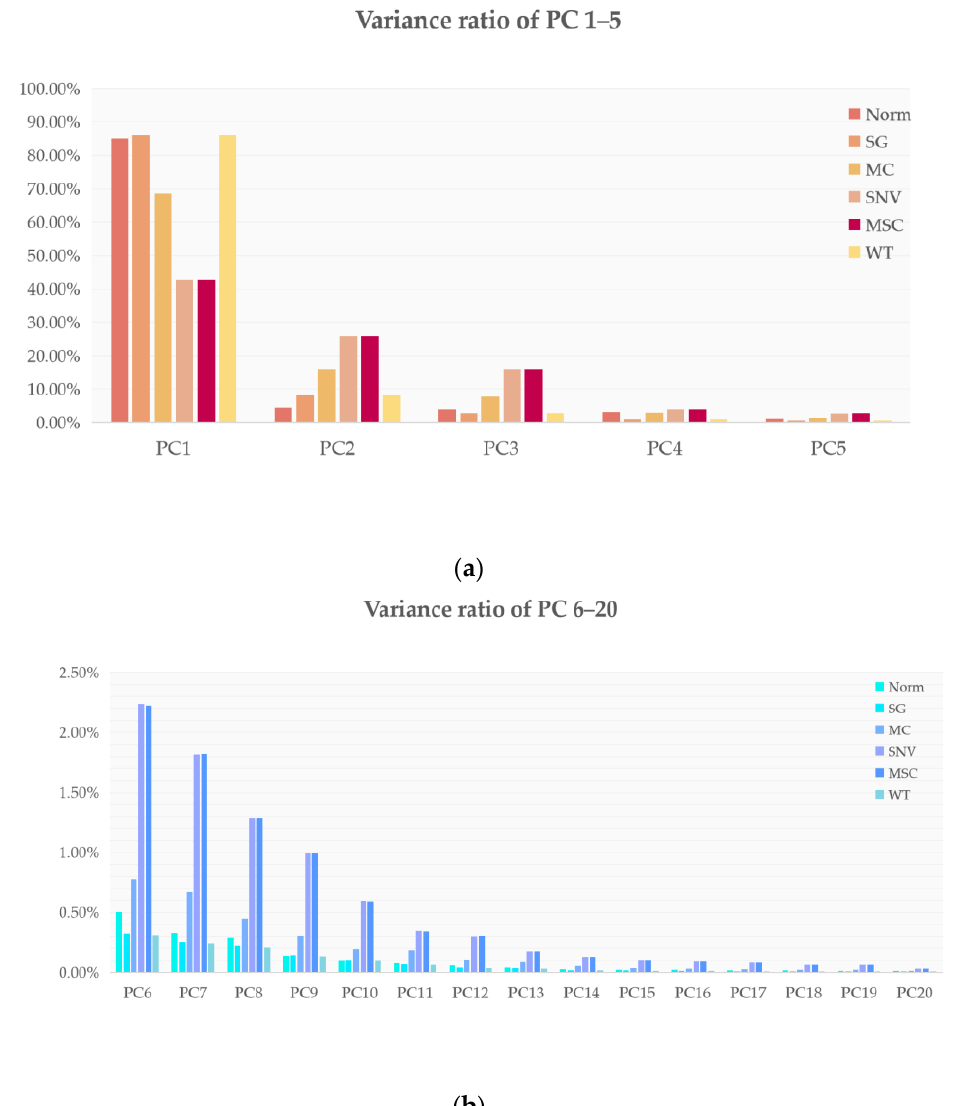
Figure 2. Twenty principal component contributions for six different data pre-processing methods: ( a ) percentage contributions of the 1st to 5th principal components for the six different data pre- processing methods; ( b ) percentage contributions of the 6th to 20th principal components for the 6 different data pre-processing methods.